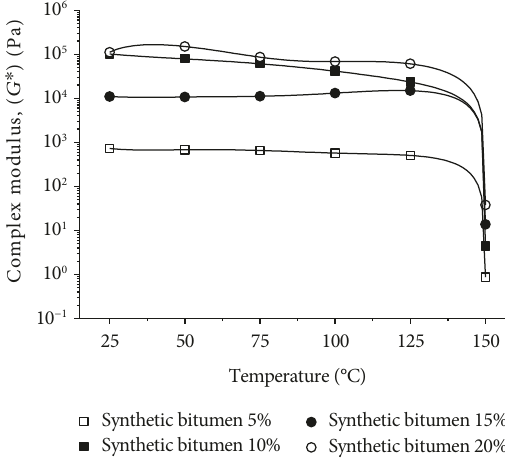
Figure 2: G ∗ versus temperature for synthetic